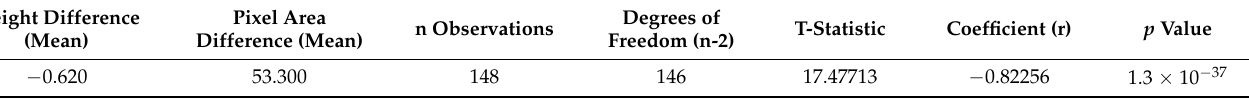
Table 4. Statistical analysis for the Pearson correlation between the weight and air cell size.